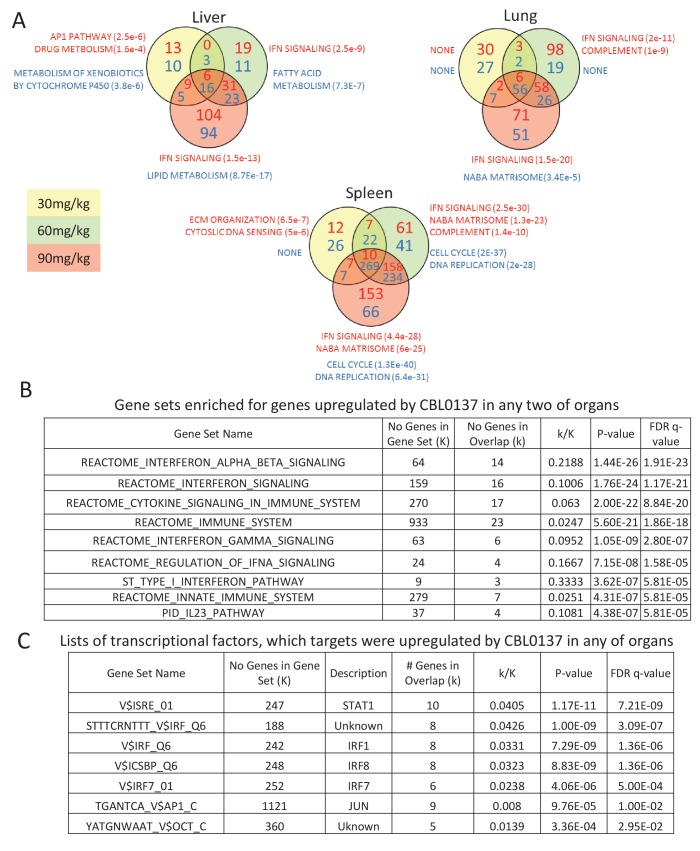
Activation of IFN response is detected in response to CBL0137 in different tissues of mice via GSEA.(A) Venn diagrams showing the number of up (red font) or down (blue font) regulated genes in response to CBL0137 together with gene set names enriched for these genes. The p-value of overlap is shown in parentheses. (B) GSEA of curated signaling pathways using the list of genes upregulated in two or more tissues in response to any dose of CBL0137. (C) GSEA of targets of known transcriptional factors using the list of genes upregulated in any of tissues in response to any of doses of CBL0137.10.7554/eLife.30842.006Figure 2—source data 1.GSEA analysis of genes downregulated in response to treatment with 30 mg/kg (sheet 1), 60 mg/kg (sheet 2) and 90 mg/kg (sheet 3) of CBL0137 in liver.10.7554/eLife.30842.007Figure 2—source data 2.GSEA analysis of genes upregulated in response to treatment with 30 mg/kg (sheet 1), 60 mg/kg (sheet 2) and 90 mg/kg (sheet 3) of CBL0137 in liver.10.7554/eLife.30842.008Figure 2—source data 3.GSEA analysis of genes downregulated in response to treatment with 30 mg/kg (sheet 1), 60 mg/kg (sheet 2) and 90 mg/kg (sheet 3) of CBL0137 in lung.10.7554/eLife.30842.009Figure 2—source data 4.GSEA analysis of genes upregulated in response to treatment with 30 mg/kg (sheet 1), 60 mg/kg (sheet 2) and 90 mg/kg (sheet 3) of CBL0137 in lung.10.7554/eLife.30842.010Figure 2—source data 5.GSEA analysis of genes downregulated in response to treatment with 30 mg/kg (sheet 1), 60 mg/kg (sheet 2) and 90 mg/kg (sheet 3) of CBL0137 in spleen.10.7554/eLife.30842.011Figure 2—source data 6.GSEA analysis of genes upregulated in response to treatment with 30 mg/kg (sheet 1), 60 mg/kg (sheet 2) and 90 mg/kg (sheet 3) of CBL0137 in spleen.